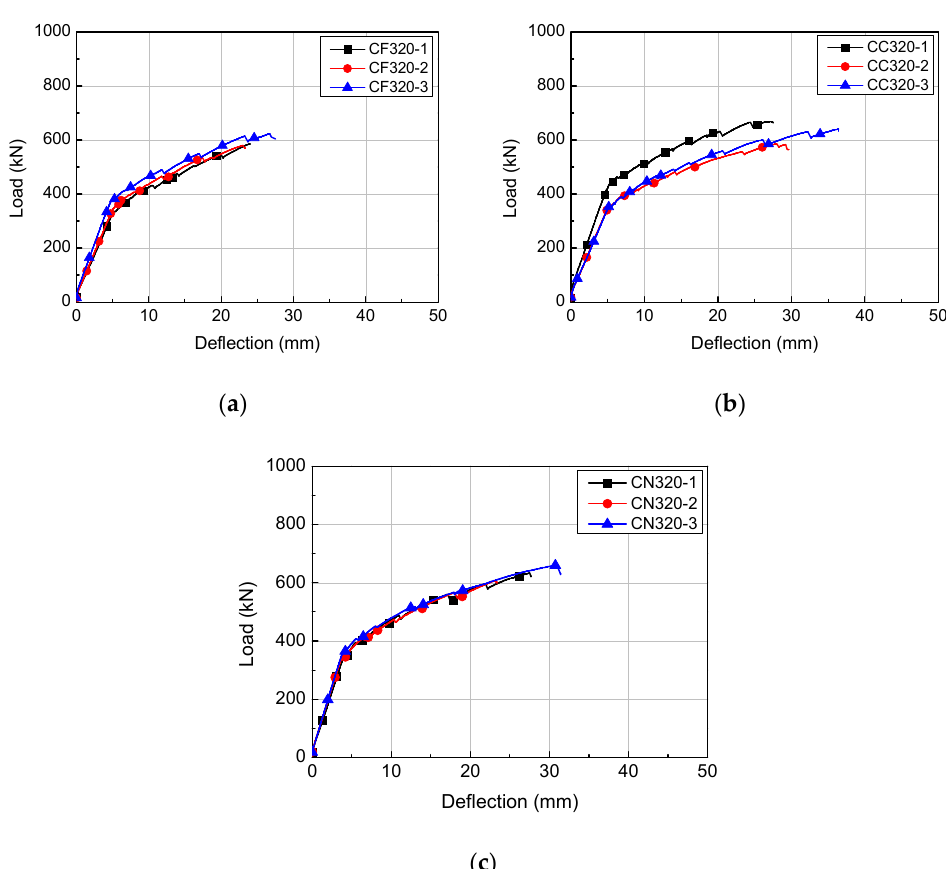
Figure 7. Load-deflection relationships of H320 series: ( a ) CF320; ( b ) CC320; ( c ) CN320.